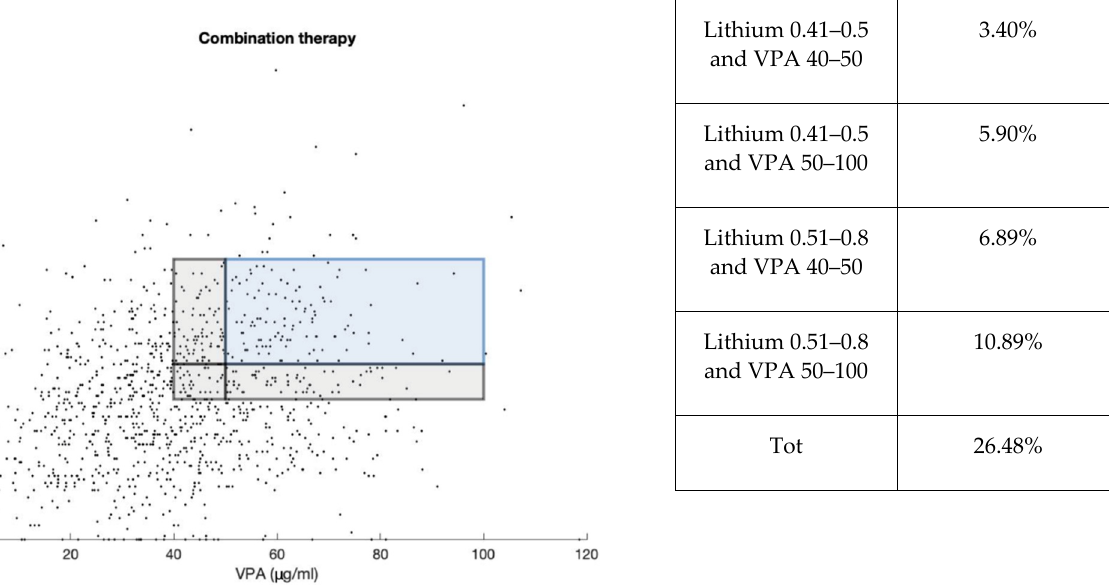
Figure 8. Scatter plot representing the distribution of lithium Cp (mmol/L) and VPA Cp ( μ g/mL) samples in combination therapy (1118). Samples in the therapeutic range of lithium (0.5–0.8 mmol/L) and VPA (50–100 μ g/mL) are highlighted in the blue area. An additional gray area shows values of lithium (0.4–0.5 mmol/L) and VPA (40–50 μ g/mL) close to the therapeutic range. These percentage values are reported in the table.